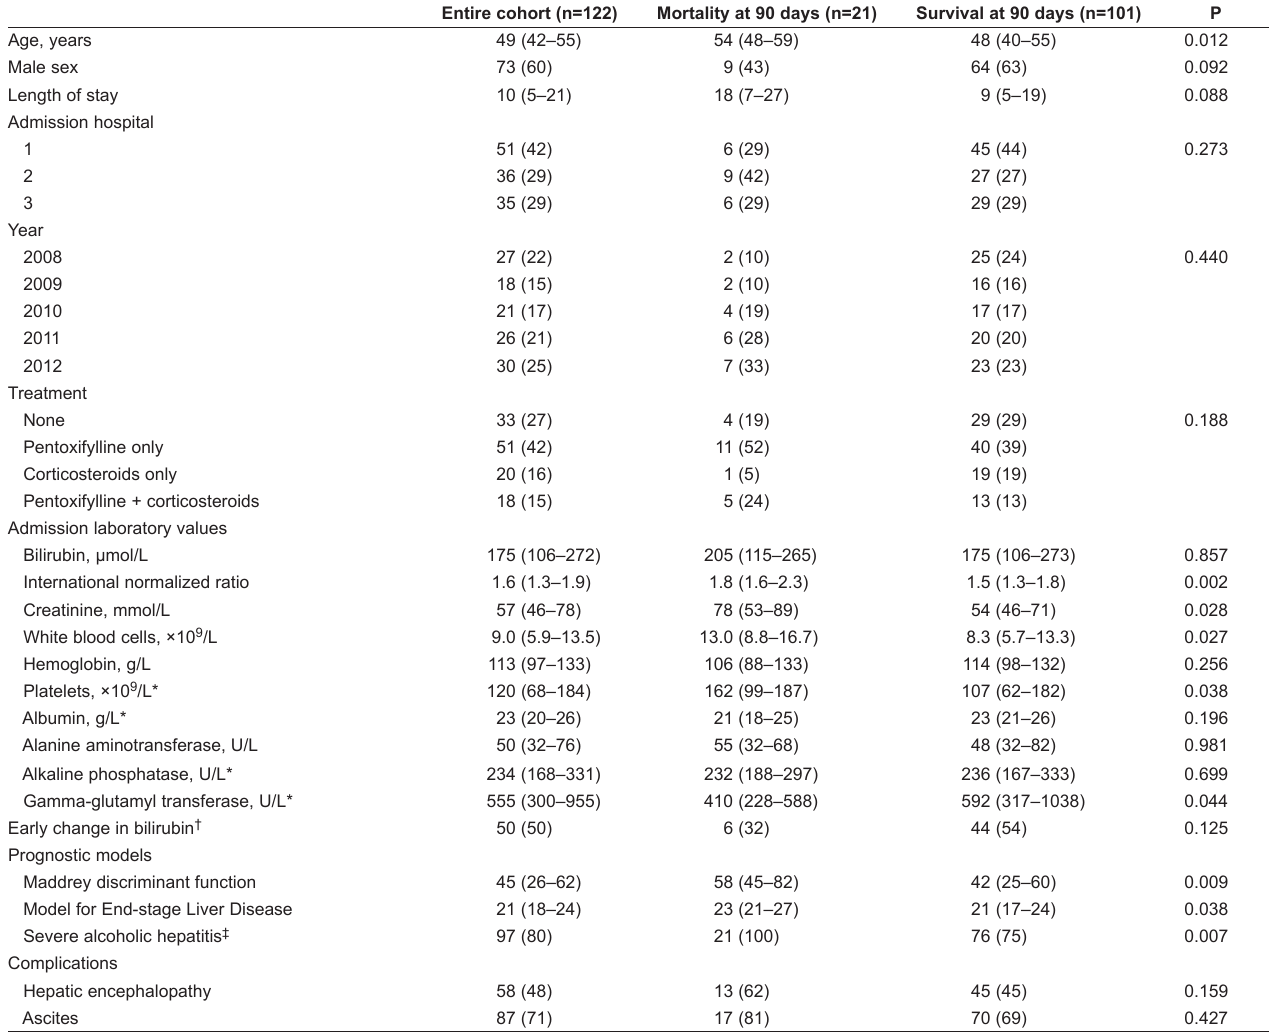
TABLE 1 Characteristics of the study